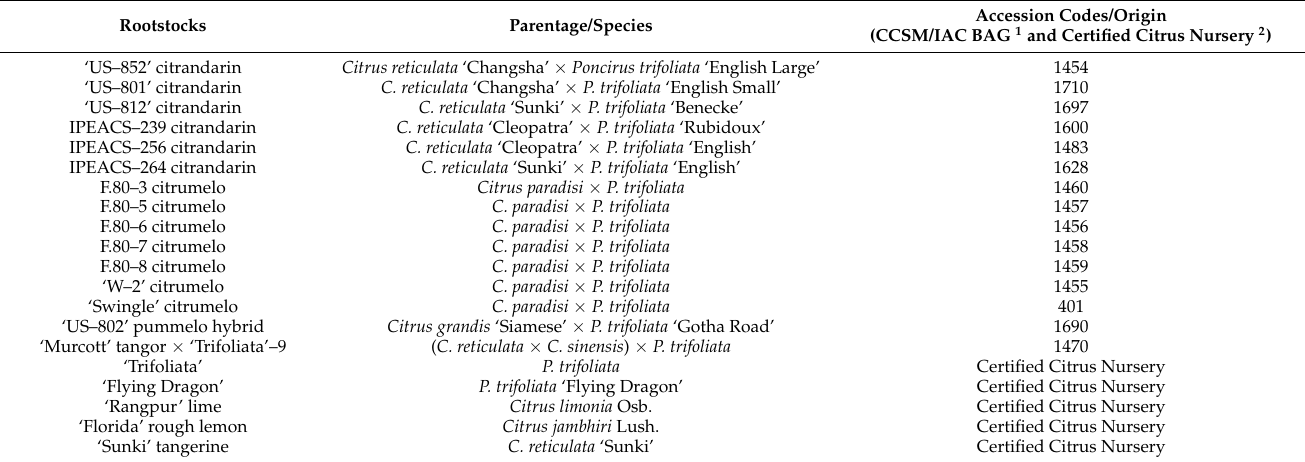
Table 1. Common names, parentage (species names), access code or origin of 20 rootstocks evaluated for ‘Valencia’ sweet orange.